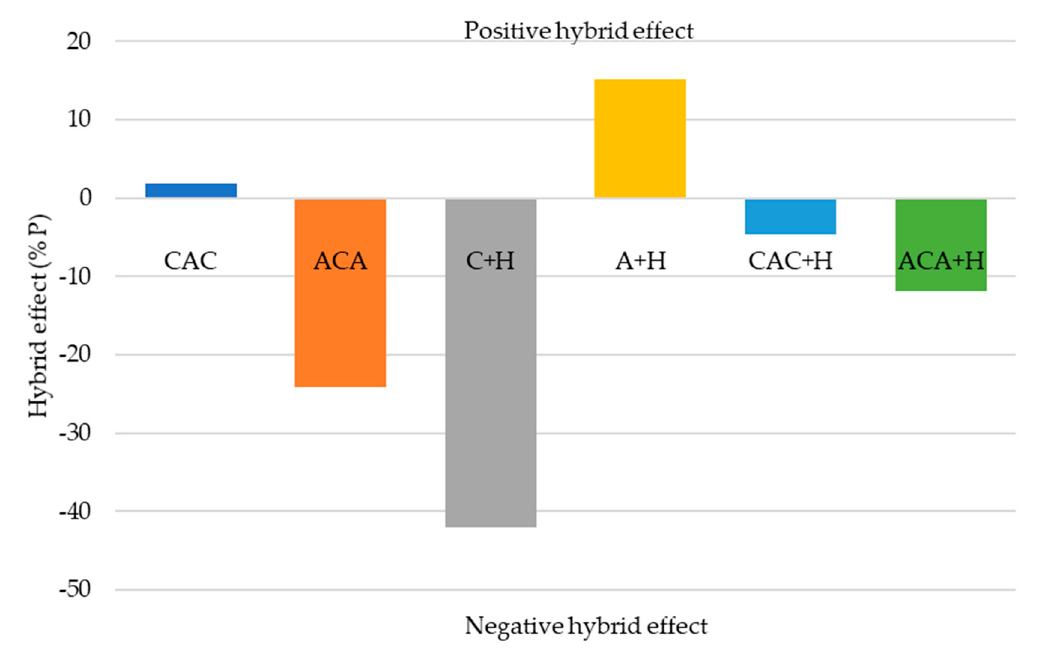
Figure 12. The percentage changes in maximum carried load (Pmax) due to hybridisation.